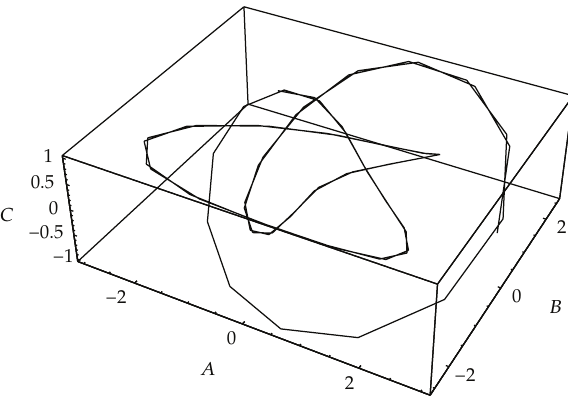
Figure 19: The knotted closed curve corresponding to the solution (cid:2) 4.13 (cid:3) with (cid:2) 3.4 (cid:3) , t ∈ (cid:4) 0 , 4 π (cid:5) , k (cid:6) 1 / 3.